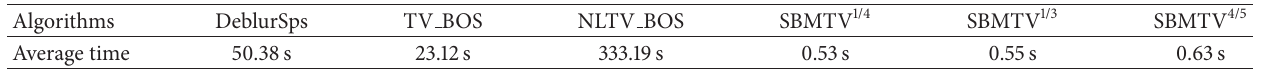
Table 2: Average time of each algorithm to restore a blurred-noisy image.